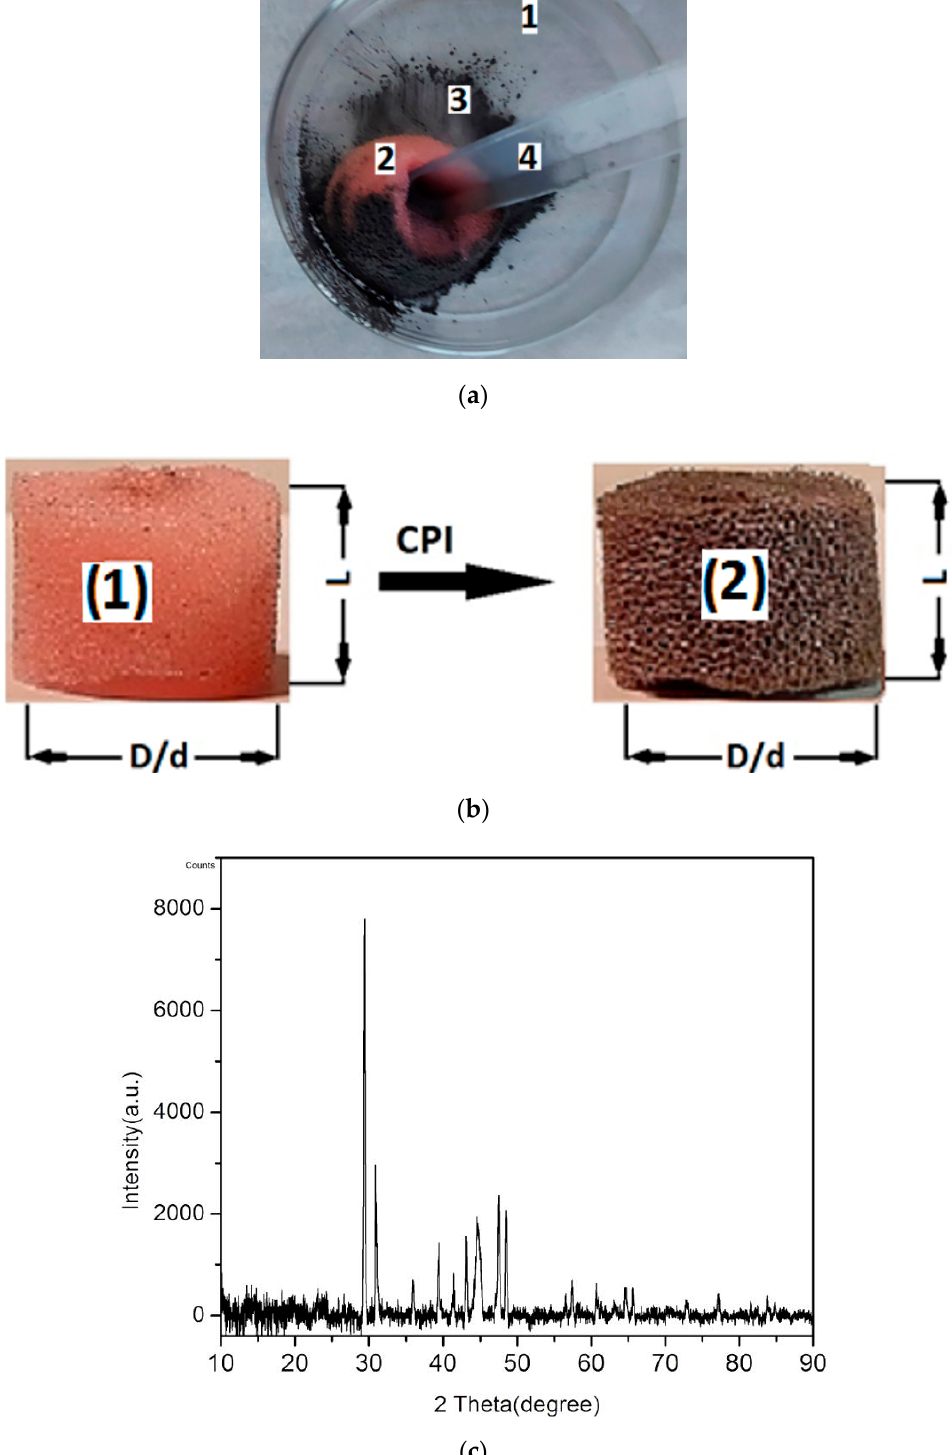
Figure 3. ( a ) MS sponge manufacturing (1—Petri dish; 2—PS; 3—CIPs; 4—glass rod); ( b ) PS before filling (1) and after filling (2) with CIPs; ( c ) XRD analysis of MS. Using the analytical balance, we measured the weights of the sponges uniformly doped with CIPs. Considering (cid:1865) (cid:3017)(cid:3007) = 0.169 g , we then calculated (cid:1865) (cid:3004)(cid:3010)(cid:3017) for the three sam- ples. Table 1 shows the weights, volumes and volumetric fractions for the samples (cid:1839)(cid:1845) (cid:3036) ,